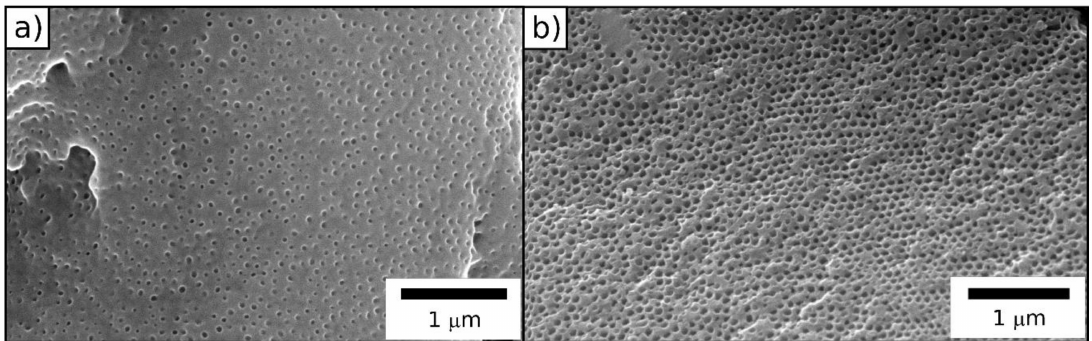
Figure 6. Mass loss of the colloidal crystal made of particles from FRP during the thermal treatment.